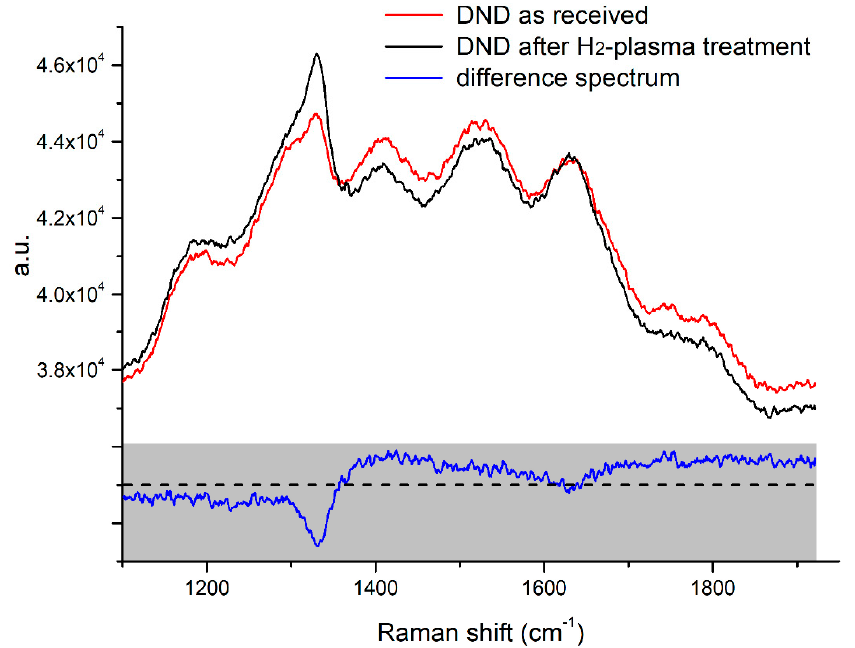
Figure 2. Raman spectra of DNDs sample as received (red line), after the plasma treatment (black line), and the difference spectrum (blue line).